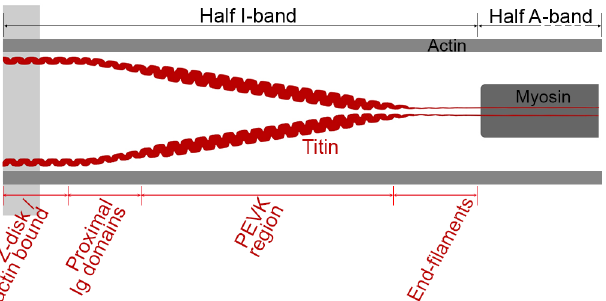
Fig 1. Sketch of titin strands in a half sarcomere. While a single titin strand spans the whole half sarcomere only a part of titin located in the half I-band is extensible.